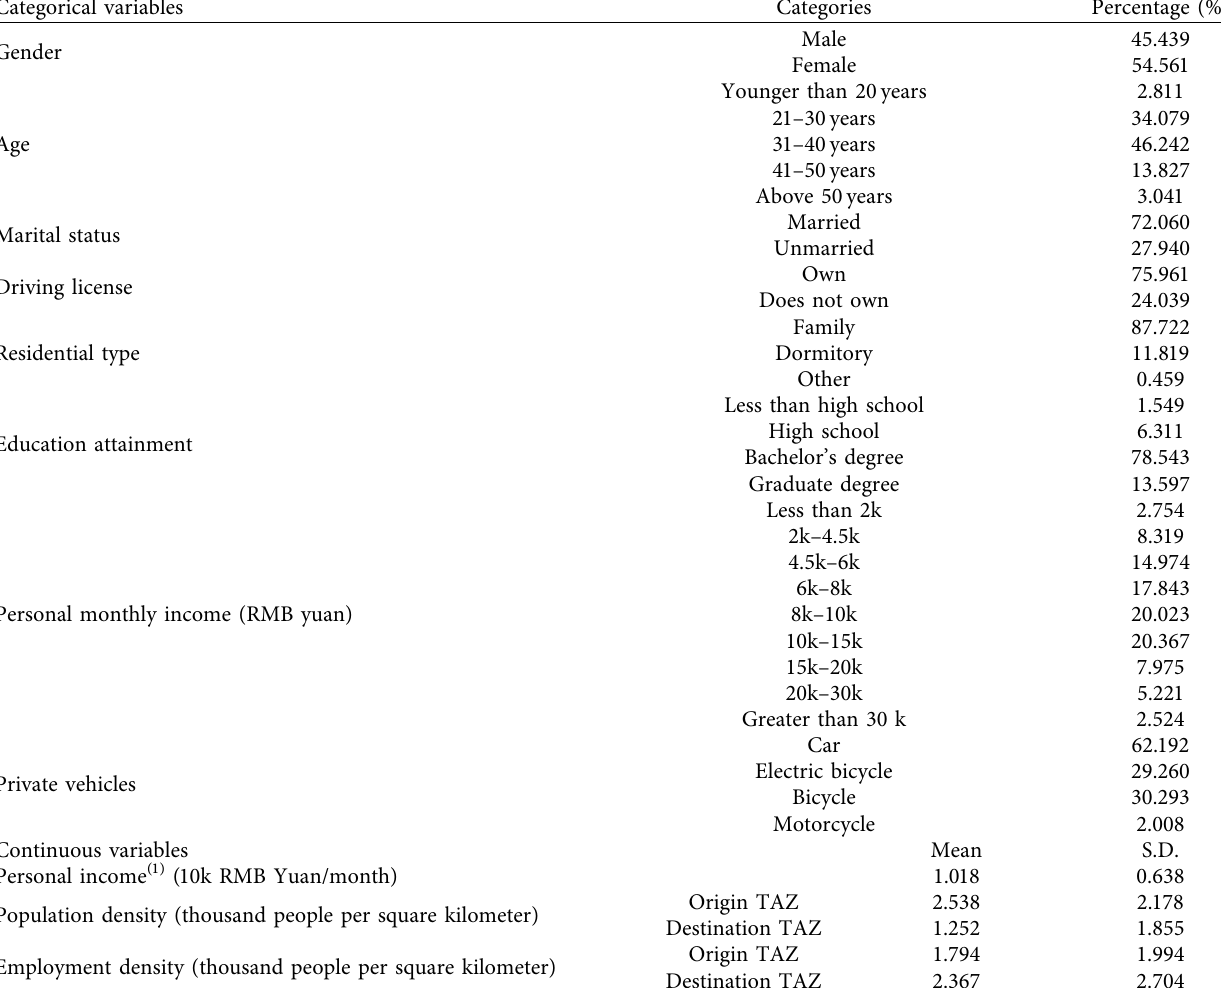
Table 4: Sample characteristics ( N �